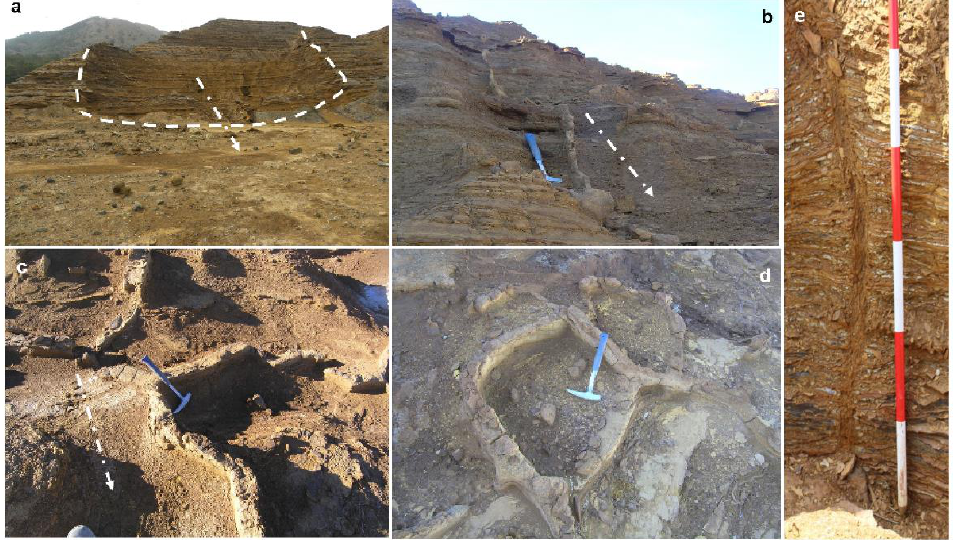
Figure 11. ( a ) View of the breach in the wall of the impoundment in landslide four (LL4). ( b ) Close-up view of a sand dike cross cutting the subhorizontal tailings bedding. Plan view of the polygonal arrangement of sand dikes on the LL4 surface ( c ) and lagoon four (Lg4) ( d ). ( e ) View of a sand dike exposed on the breach plane of landslide five (LL5). The discontinuous arrow indicates the direction of the runoff.